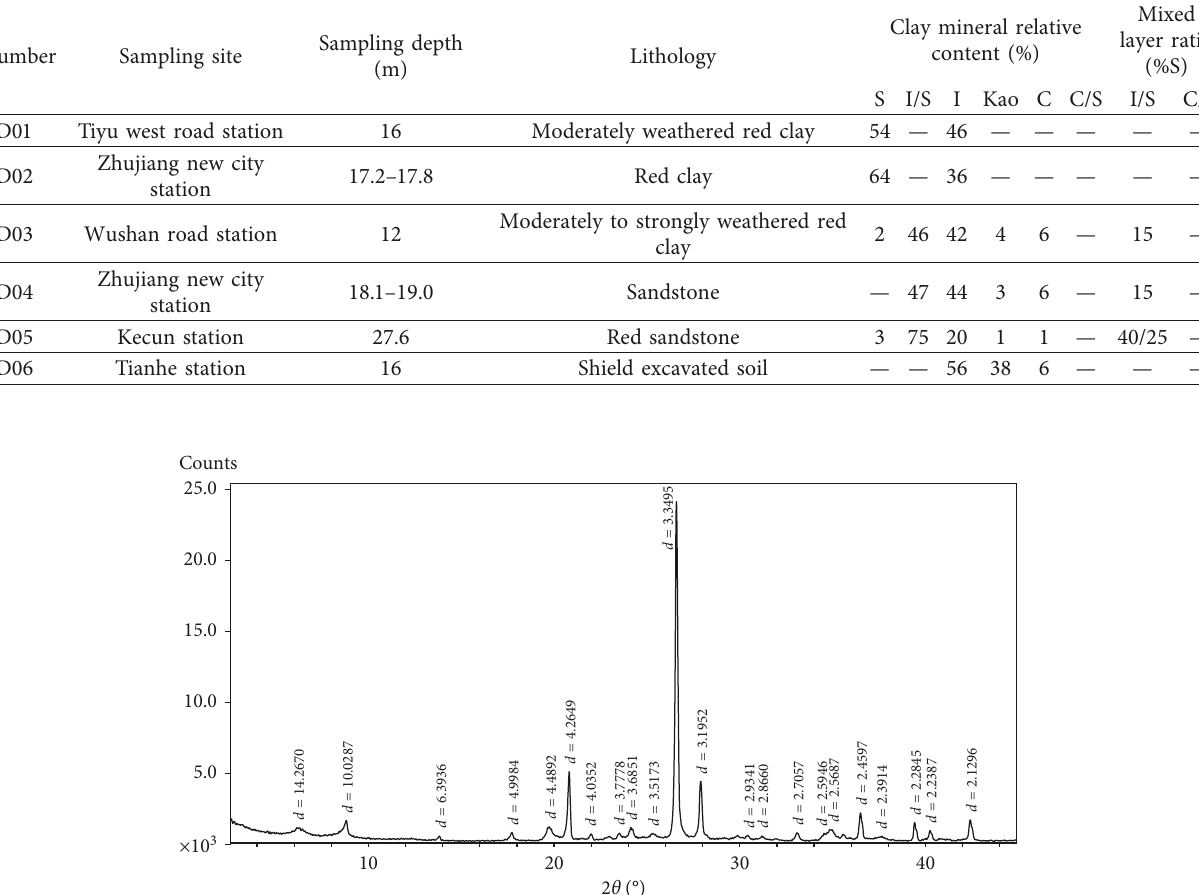
Figure 8: Total mineral X-ray diffraction pattern of red clay samples in Zhujiang new city